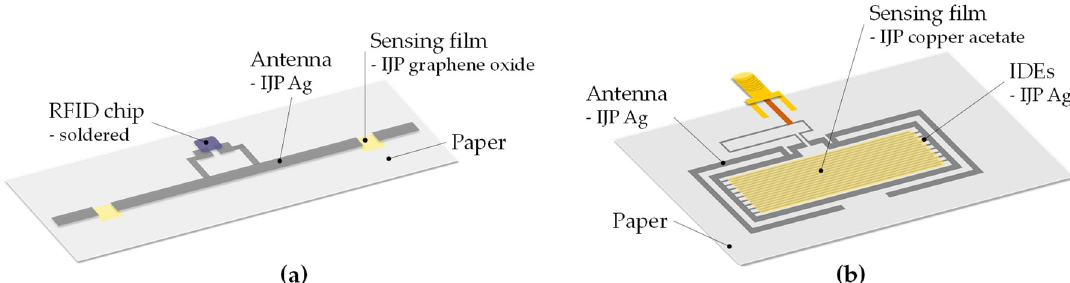
Figure 6. Fully inkjet-printed wireless gas sensors: ( a ) Graphene based sensing layer [40]; ( b ) copper acetate based sensing layer [38].